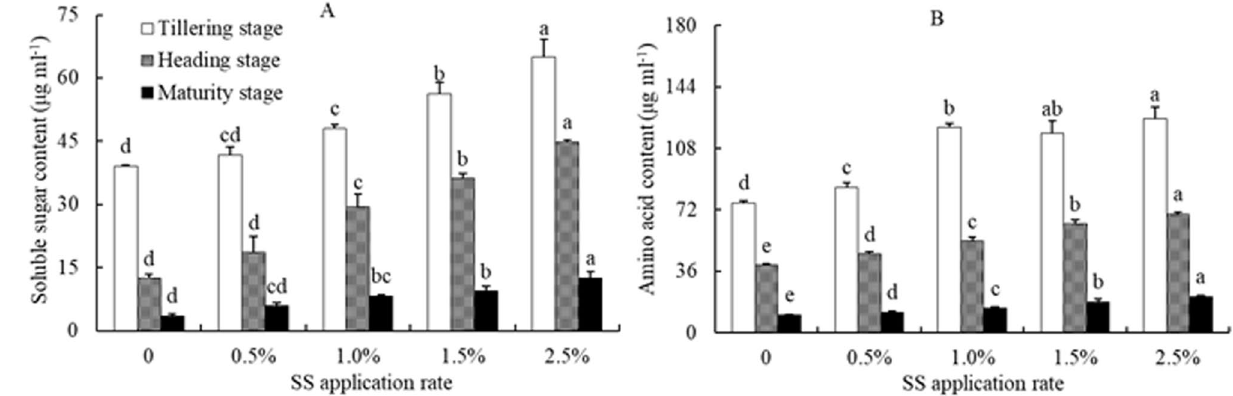
Figure 4. Effects of sewage sludge (SS) application on the concentration of soluble sugar ( A ) and amino acid ( B ) in the bleeding sap of rice plant in salt-affected mudflat soil. Columns with different letters show significant difference between SS application rates at p < 0.05 by LSD’s multiple range